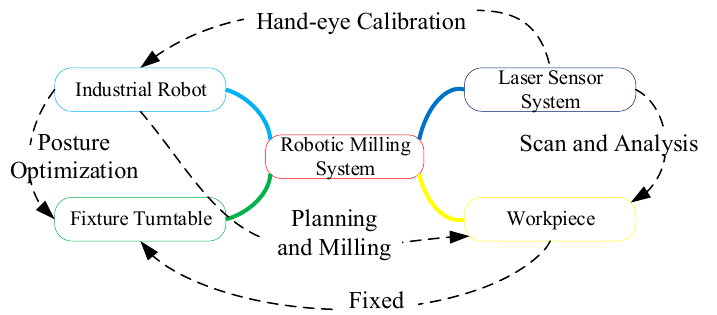
Figure 12. Robotic milling process system.